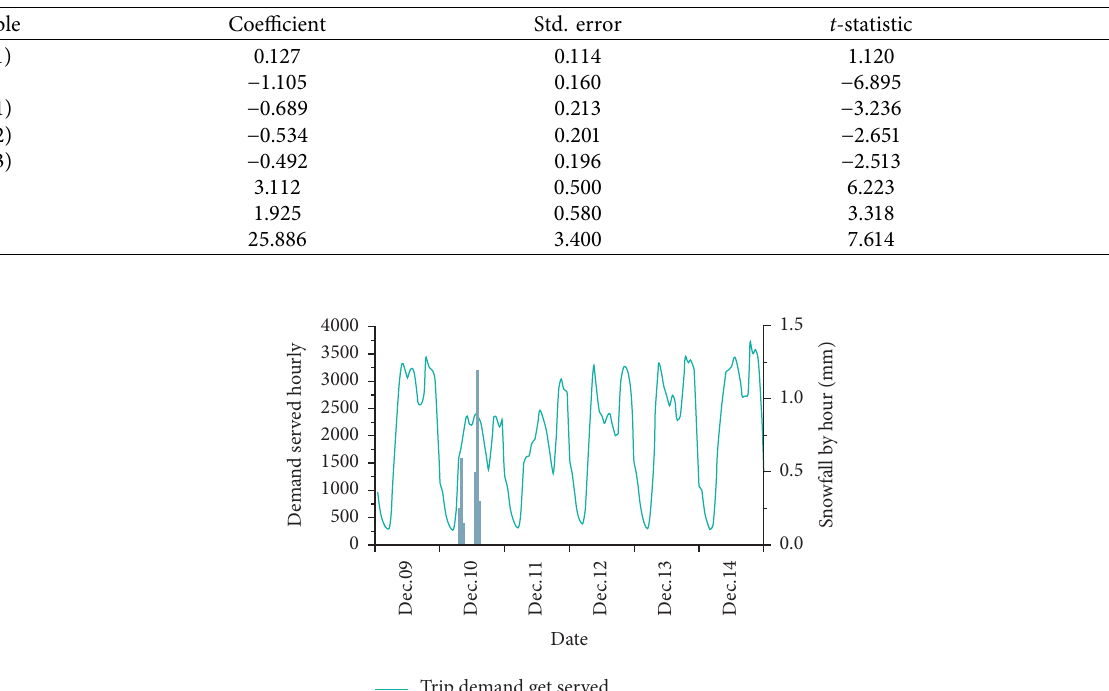
Table 5: Regression results.